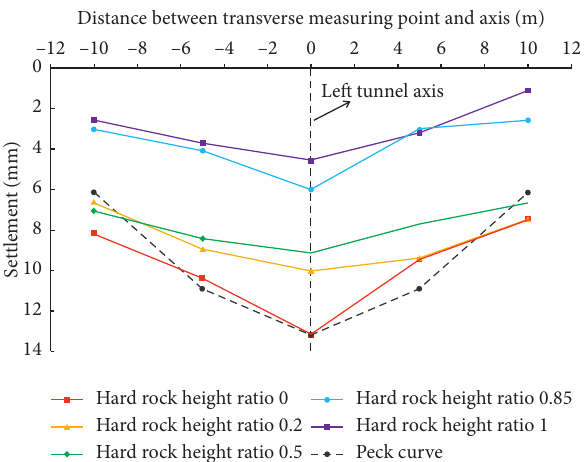
Figure 7: Transverse surface settlement curves of different hard rock height ratios.